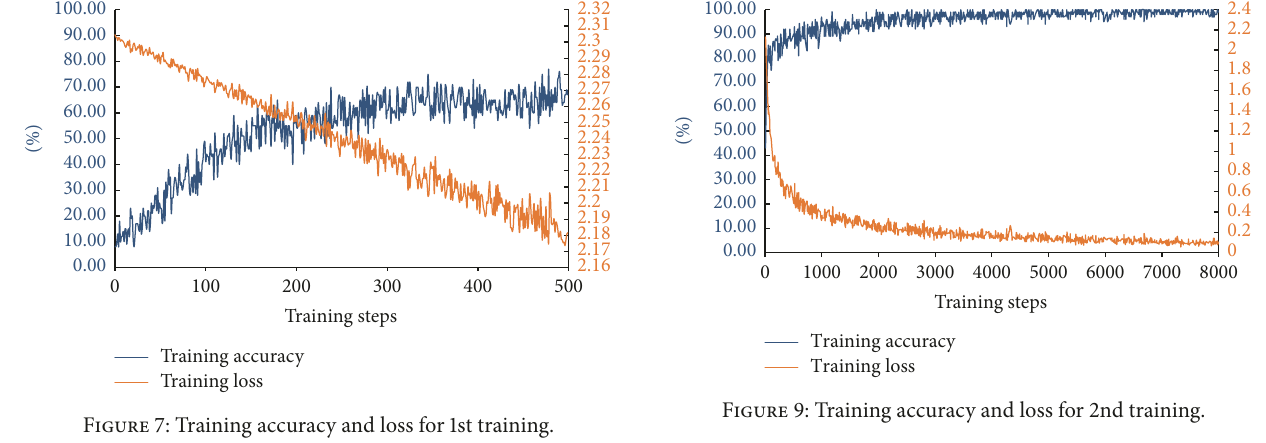
Figure 7: Training accuracy and loss for 1st training.